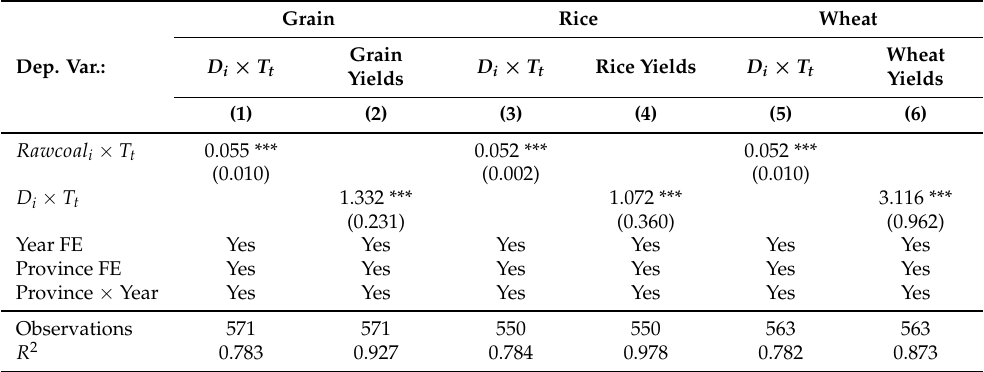
Table 8. Instrumental variables estimation. Grain Rice Wheat Dep.